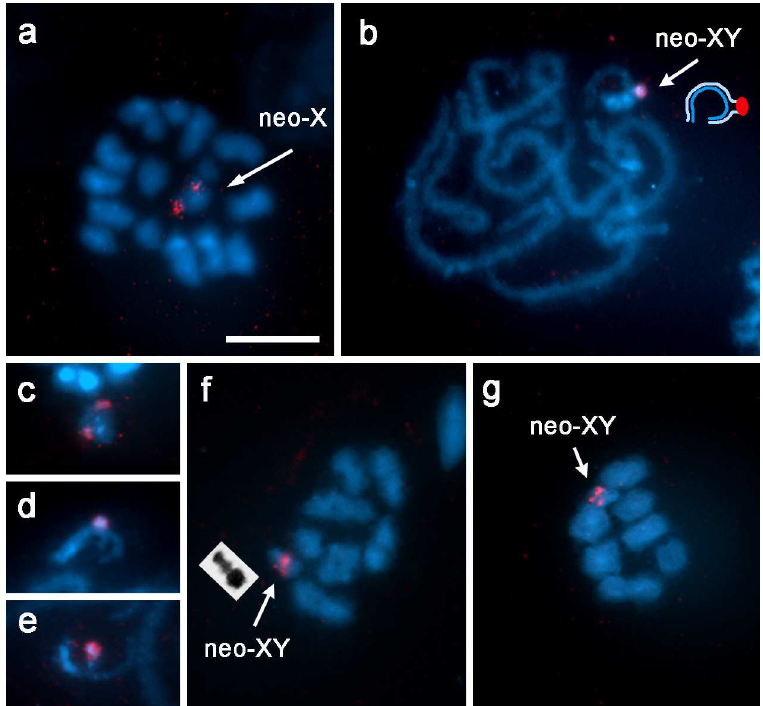
Figure 2. Rhionaeschna planaltica (2n = 16, n = 7 + neo-XY). Localization of rDNA by FISH with 18S rDNA probes (red signals) ( a – g ). Giemsa staining (inset in f ). ( a , c ) Spermatogonial prometaphase; ( b , d , e ) pachytene; inset in ( b ): schematic drawing of the neo-XY bivalent (neo-X in white, neo-Y in blue, probe signals in red); ( f ) diakinesis, inset: neo-XY bivalent; ( g ) metaphase I; ( c ) shows a neo-X chromosome to illustrate the subterminal position of the signal; ( d , e ) show selected neo-XY bivalents from other cells. Bar = 10 μm.